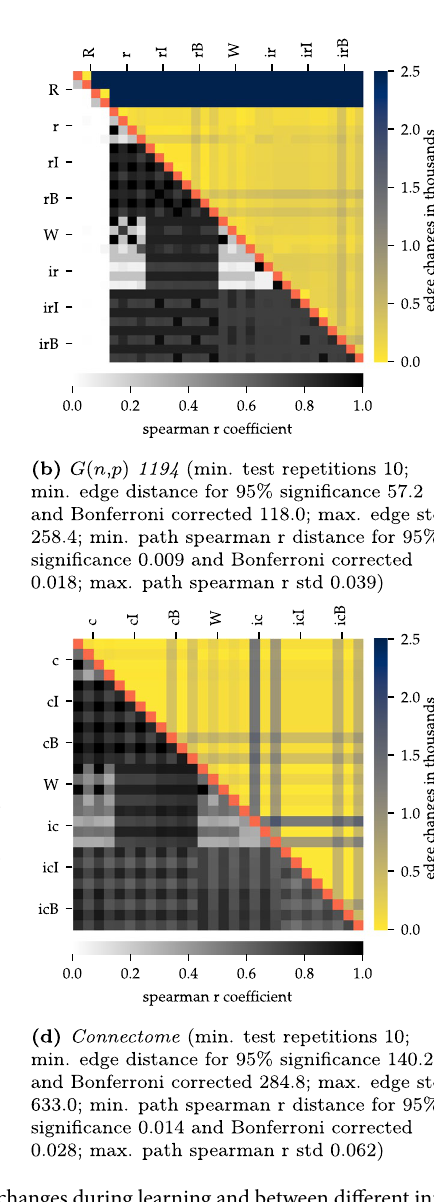
structure implantation was found to be very similar. Both problems, MNIST 41 and Fashion-MNIST 42 , were solved with identical accuracy for each data set, which disclosed the relevance of the structure even without the weights. This was additionally supported by Fig. 4, showing that during learning only minimal changes were applied to the weights. Indeed, a quite familiar observation was drawn from Gaier and Ha 25 as they figured out the importance of the architecture in contrast to the previously established interest in the weights. To put this influence of the weights to the test, we performed experiments with either disturbed or blocked weights and neuron offset values, respec- tively. A disturbance of the value means that a normally distributed noise was added before each learning step. In blocked runs the disturbed values were not trainable (further information can be observed in the “Methods”